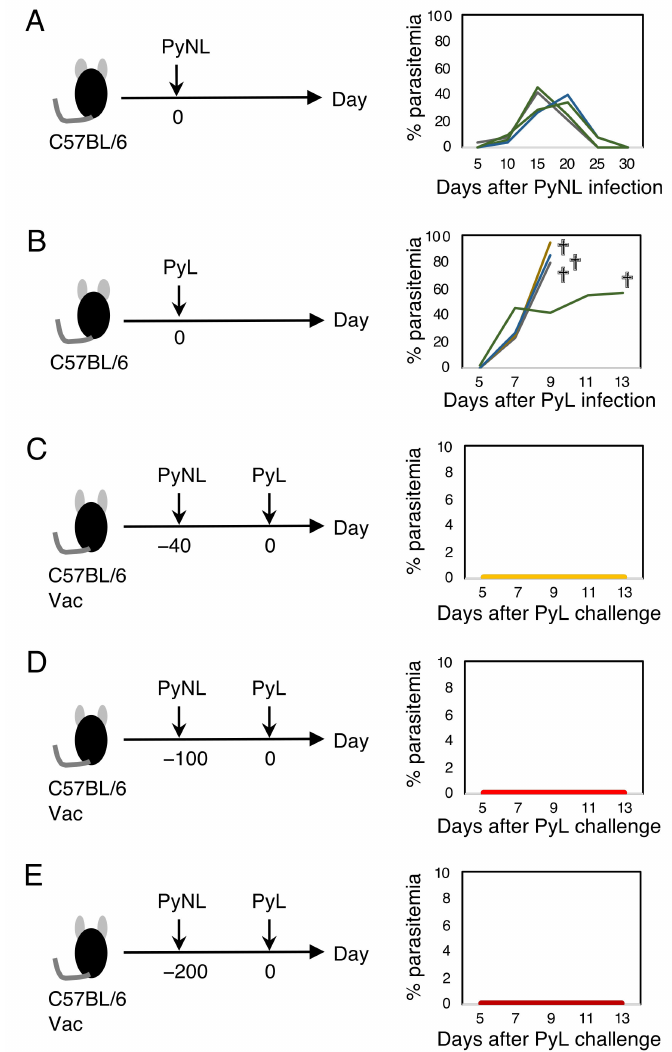
Figure 1. Live vaccination with Plasmodium yoelii 17XNL (PyNL) protected mice from the lethal P. yoelii 17XL (PyL). ( A ) C57BL/6 mice were infected with PyNL pRBC (left panel) and parasitemia was monitored (right panel). All mice cleared the parasite within one month. Each line shows parasitemia of one mouse (N = 4). A representative dataset is shown from more than 15 different independent experiments. ( B ) C57BL/6 mice were infected with PyL pRBC (left panel) and parasitemia was monitored. Each line shows parasitemia of one mouse (N = 4). “†” indicates death. A representative dataset is shown from more than 10 independent experiments. (C) At forty days after vaccination with PyNL, the mice were challenged with PyL (same as (A) and (B); left panel) and parasitemia was monitored (right panel; N = 57 from pooled independent experiments). There were no parasites detected in PyNL-vaccinated mice after PyL challenge infection (Vac). (D) At one hundred (N = 10) and (E) two-hundred days after Vac (N = 10), the mice were challenged with PyL. Data are pooled from two independent